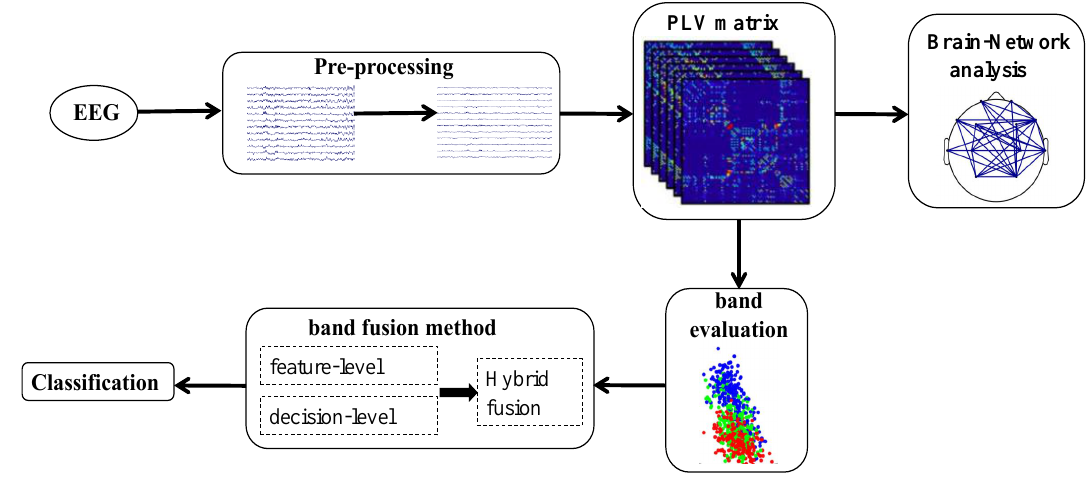
Figure 2. The flow diagram of the proposed